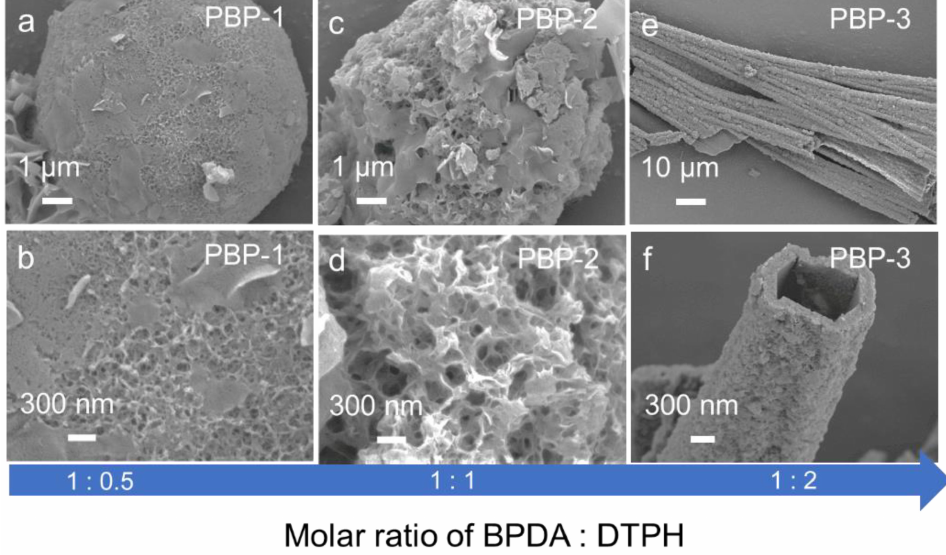
Figure 5. SEM images of ( a , b ) PBP-1, ( c , d ) PBP-2, and ( e , f ) PBP-3. The crystal structures of the dynamic covalent polymers PAP and PBP were analyzed by X-ray diffraction (XRD). As can be seen from Figure 7, all the polymers had two broad diffraction peaks around 17 ◦ and 25 ◦ , indicating that the dynamic covalent polymer had an amorphous structure